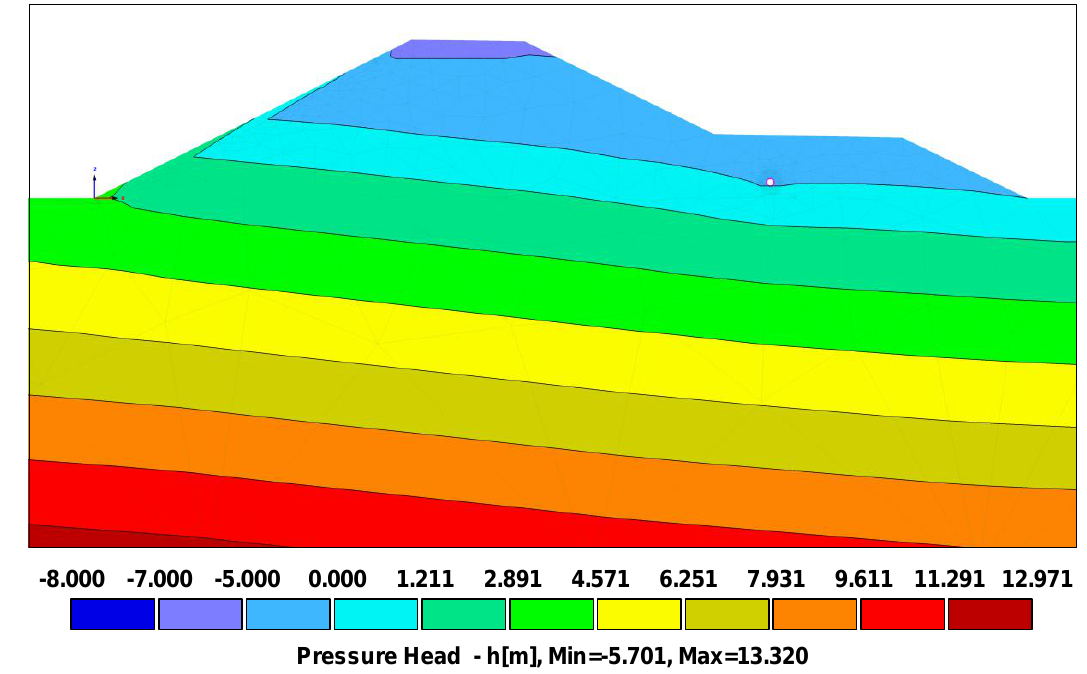
Figure 15. Piezometric pressure at steady state at a 3.32 m water level in the reservoir.